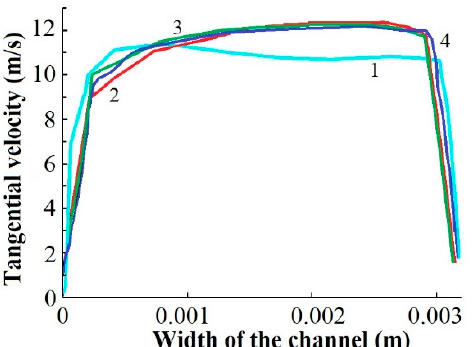
Figure 15. Distribution of tangential velocity u y ; reference lines for different channel lengths (1–4): 1— l chan = 0 (inlet), 2— l chan = 0.007 (m), 3— l chan = 0.014 (m); 4— l chan = 0.021 (m).